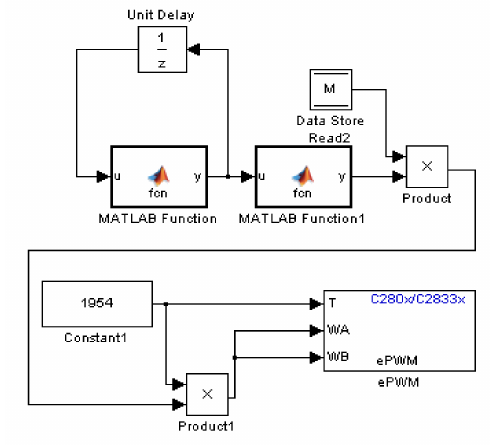
Figure 4. PWM control model.